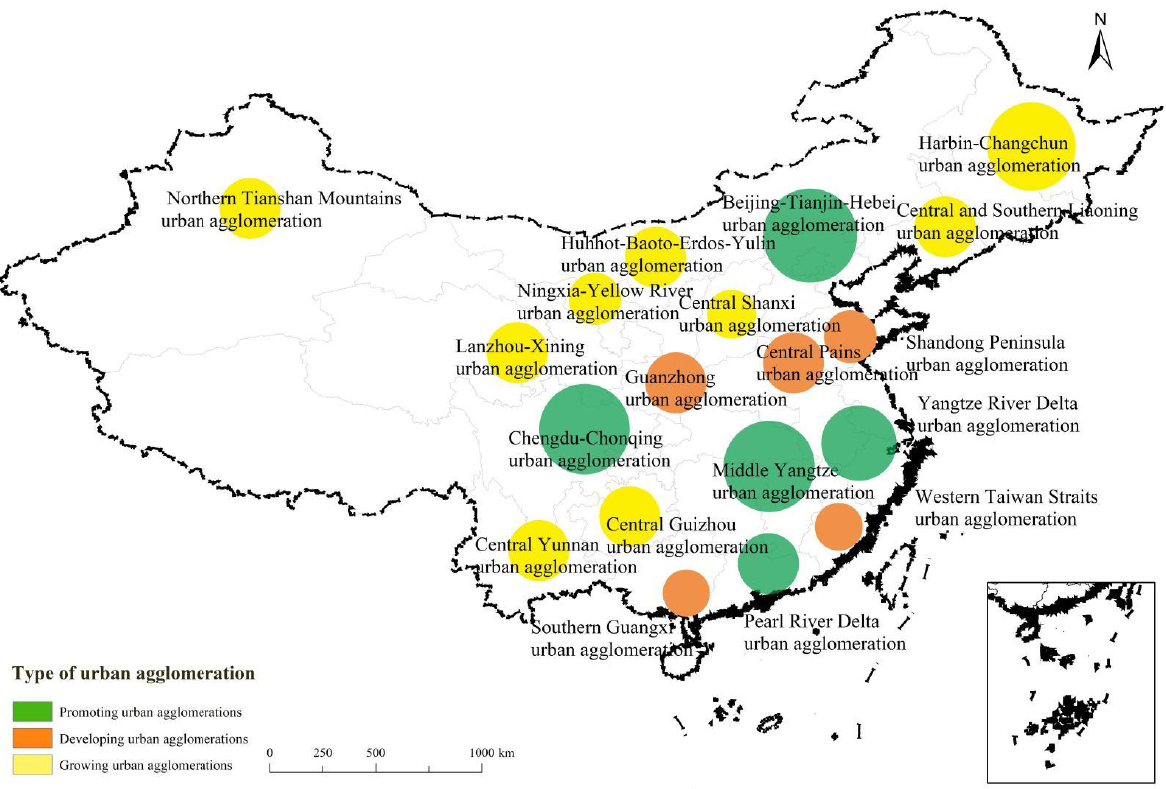
Figure 2. Distribution of China’s urban agglomerations. Note: The map of China is drawn to the standard scale, and the review number is GS(2019)1822. There is no modification to the base.